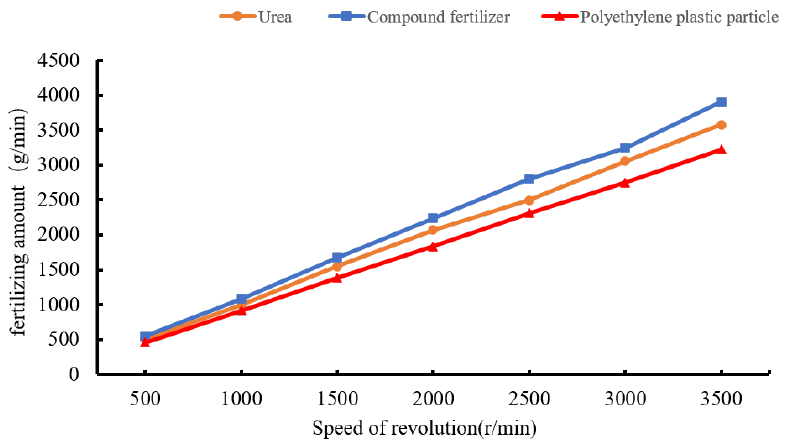
Figure 10. Actual fertilizer discharge amount at different rotating speeds. Table 2. Correlation analysis between different fertilizer rotation speeds and fertilizer discharge. Fertilizer Type p -Value R -Value Urea Compound